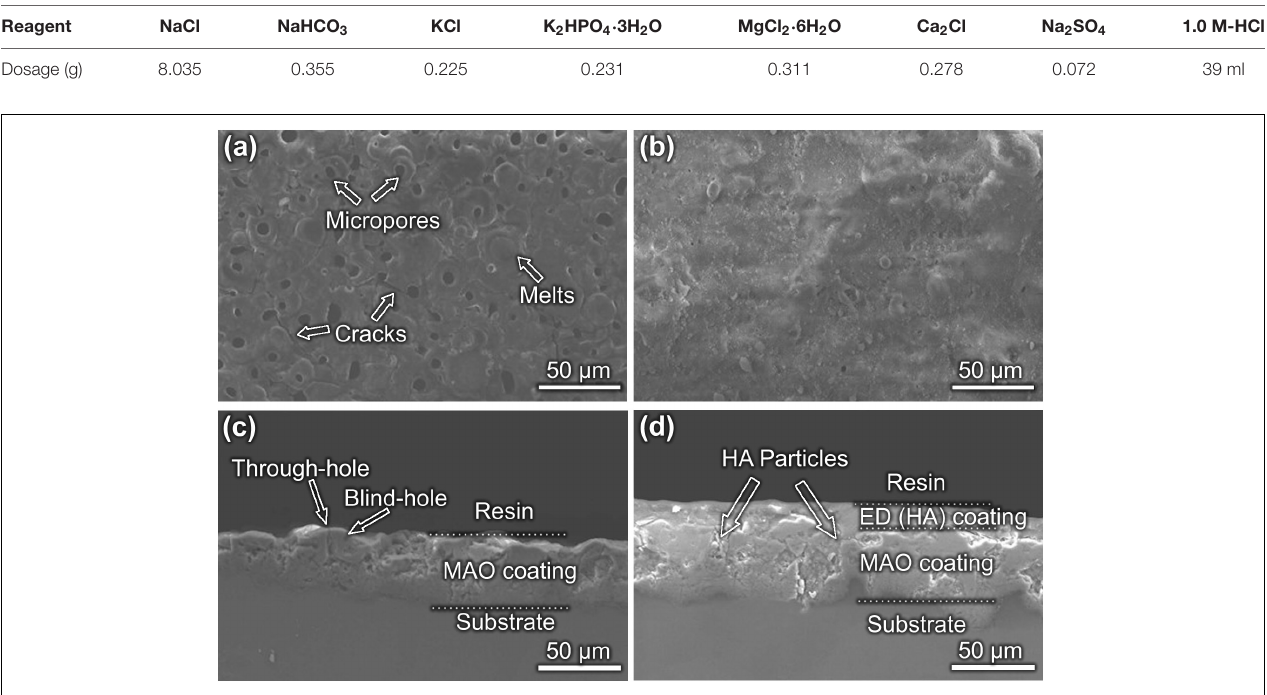
FIGURE 1 | Morphologies of the coatings (a) surface morphology of MAO coating; (b) surface morphology of MAO-ED coating; (c) cross-section morphology of MAO coating; (d) cross-section morphology of MAO-ED coating.